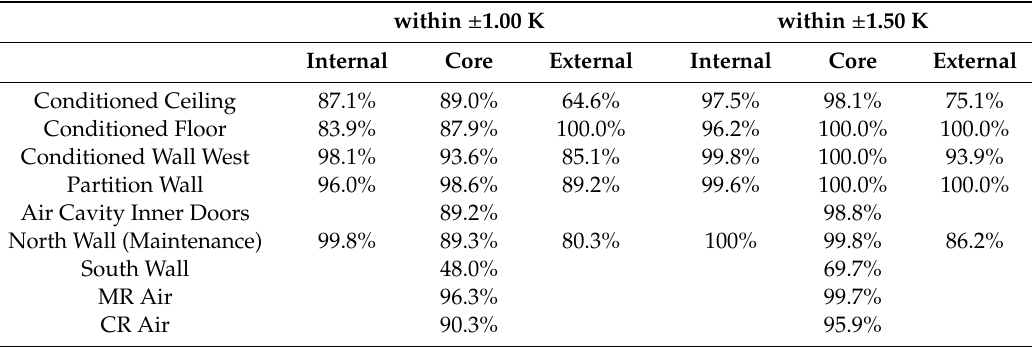
Table 5. Percentile of simulated time steps within precision